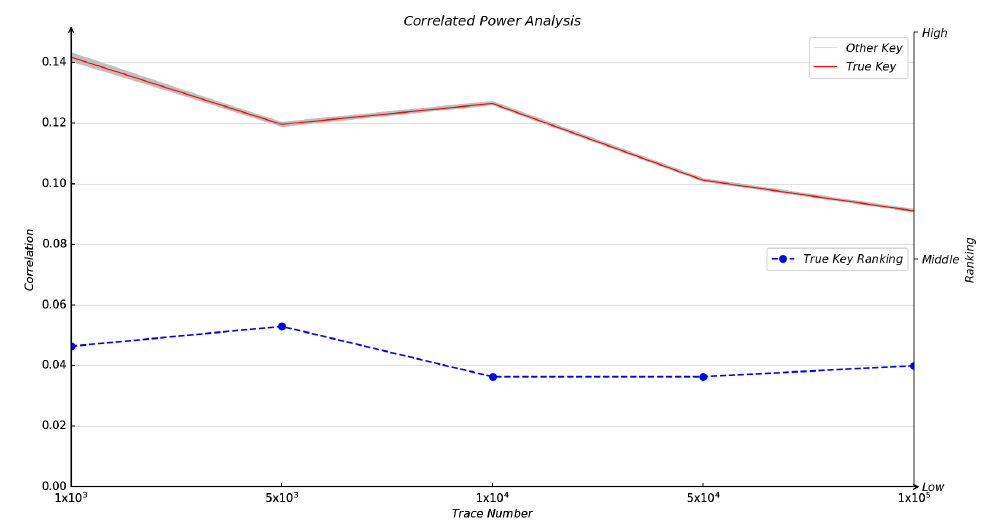
Figure 16. Group E: CPA result of experiment with 4 rounds calculated by software.